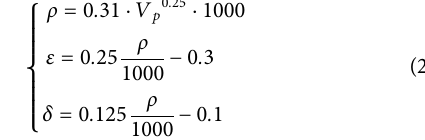
FIGURE 2 Diagram of seismic wave fi eld